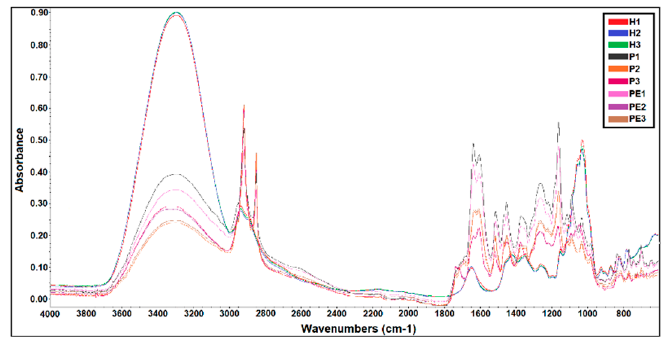
Figure 1. FTIR spectra of the samples.